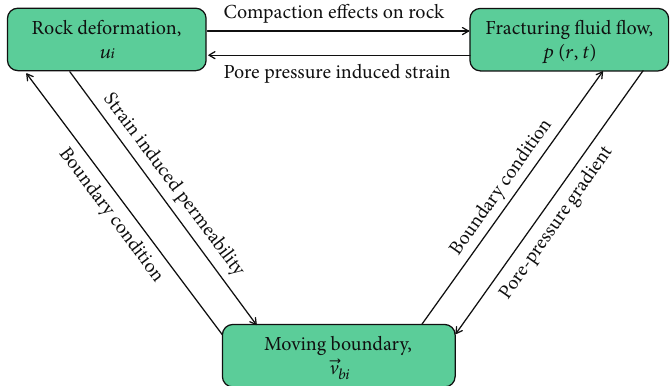
Figure 2: Interaction e ff ect among rock deformation, fracturing fl uid fl ow, and moving boundary method. Table 3: Computational parameters of bedding shale for numerical simulation.